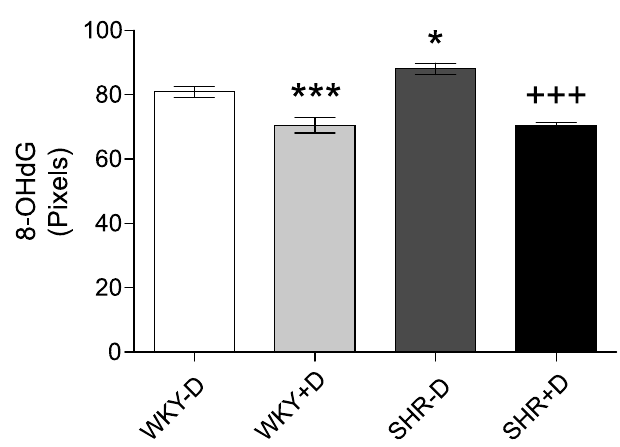
FIGURE 4 - Quantification of 8-OHdG in renal tissue. Error bars indicate SEM. * p < 0.05, *** p < 0.001 compared to WKY-D, and +++ p < 0.001 compared to SHR-D. (ANOVA followed by the Bonferroni